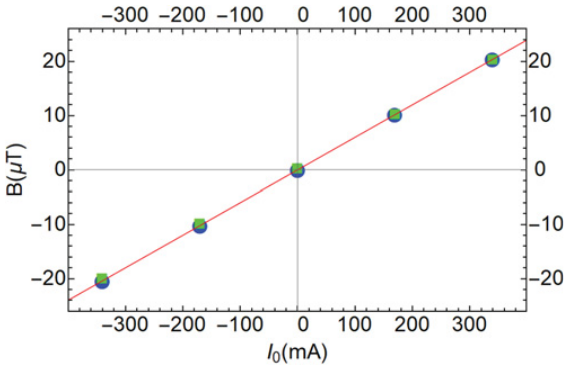
Figure 5. Plot showing the B 0 magnetic field measured by 199 Hg (indicated by blue dots) and 133 Cs (indicated by green squares) magnetometers as a function of B 0 coil